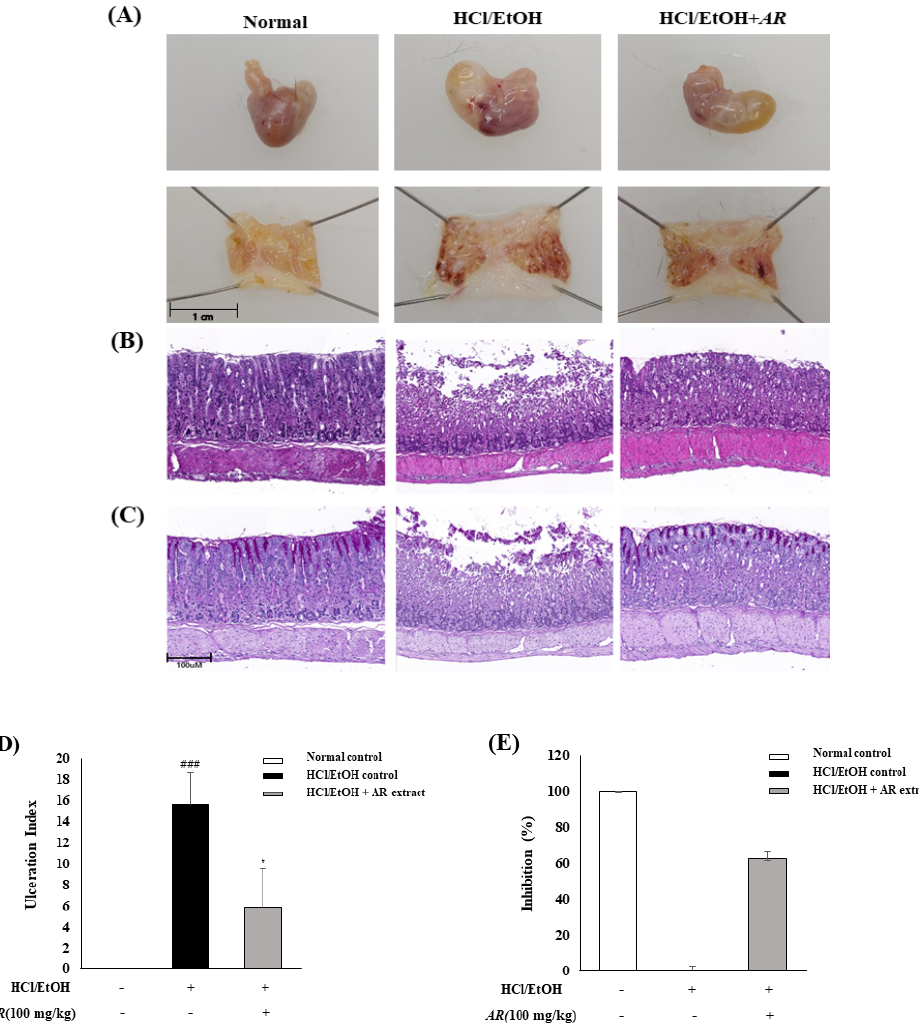
Figure 4. Effects of A. rugosa extracts (100 mg/kg/day) on the macroscopic appearance of the gastric mucosa ( A ), ulceration index, inhibition rate ( D , E ), histopathological characteristics ( B ), and gastric tissue glycoprotein–Periodic acid-Schiff (PAS) staining ( C ) in HCl/EtOH-induced gastric mucosal lesions in mice. (1) Normal control; (2) HCl/EtOH control; (3) A. rugosa extracts 100 mg/kg/day. Results presented as mean ± SEM, n = 6. t -tests were performed to calculate the statistical significance, ### p < 0.001 vs. normal control and * p < 0.05 vs. HCl/EtOH control.